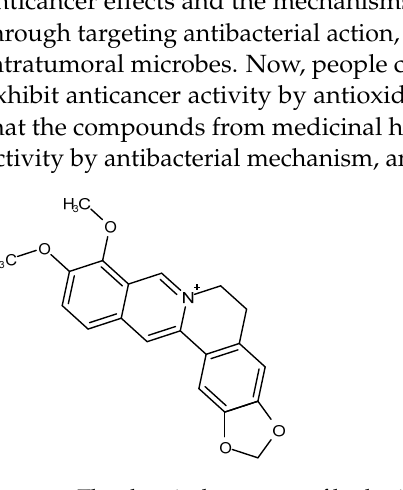
Figure 1. The chemical structure of berberine.